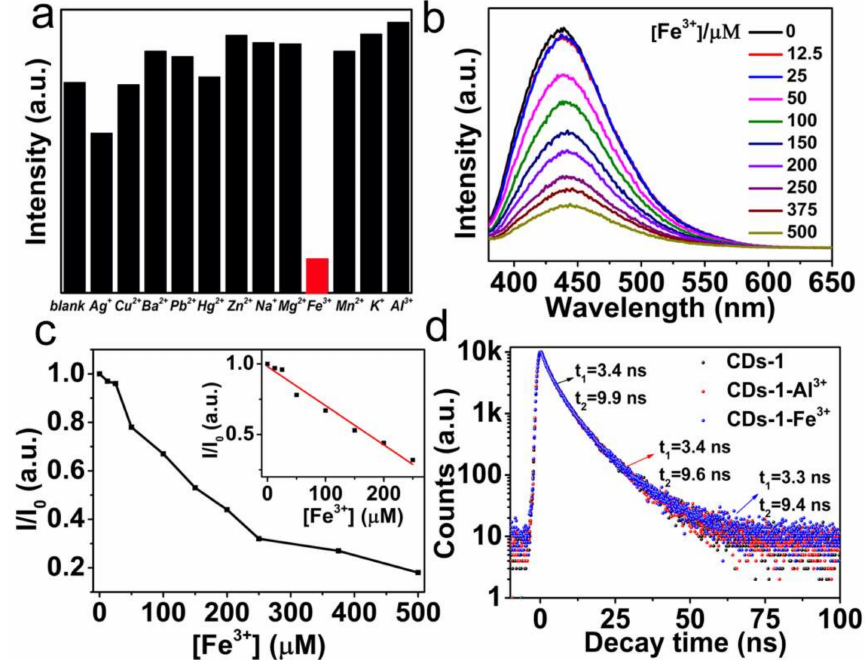
Figure 7. ( a ) Fluorescence intensities of CDs-1 in the presence of different metal ions under 365 nm excitation (the concentration of metal ions and CDs-1 is 500 µ M and 1 mg/mL, respectively); ( b ) Emission spectra of CDs-1 with different concentrations of Fe 3+ ions; ( c ) The plot of I/I 0 versus the concentration of Fe 3+ ions, inset: the linear relationship between I/I 0 and Fe 3+ ion concentration. (I and I 0 is the emission peak intensity of CDs-1 under 365 nm excitation with and without Fe 3+ ions, respectively); ( d ) Fluorescence decay curves and fitting results of CDs-1, CDs-1 with Al 3+ (CDs-1-Al 3+ ), or Fe 3+ ions (CDs-1-Fe 3+ ),